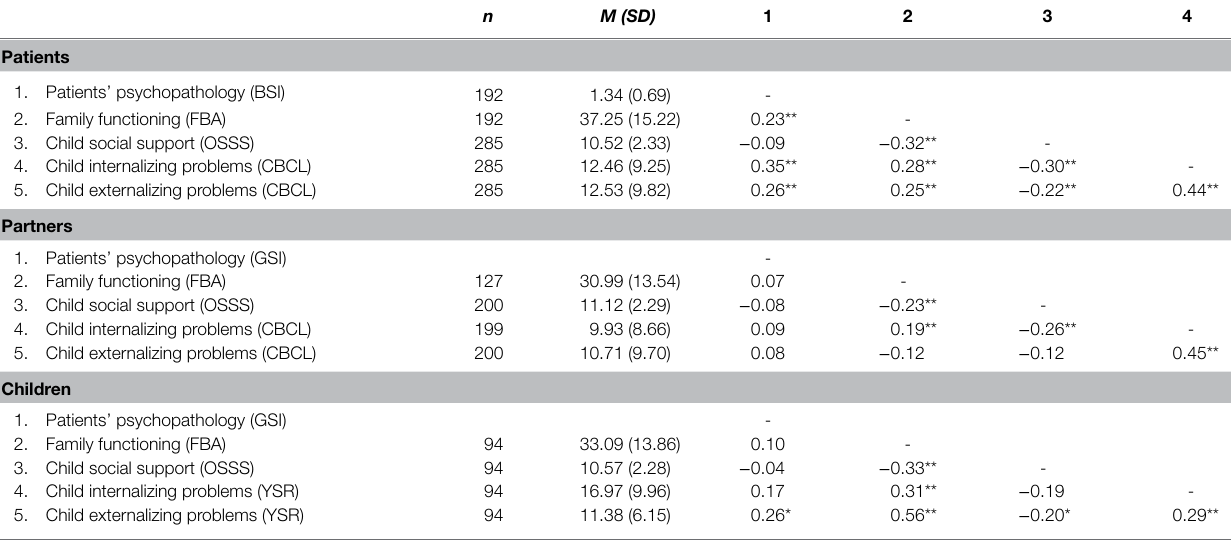
TABLE 2 | Means, SD, and intercorrelations of study variables from the three different rating perspectives.